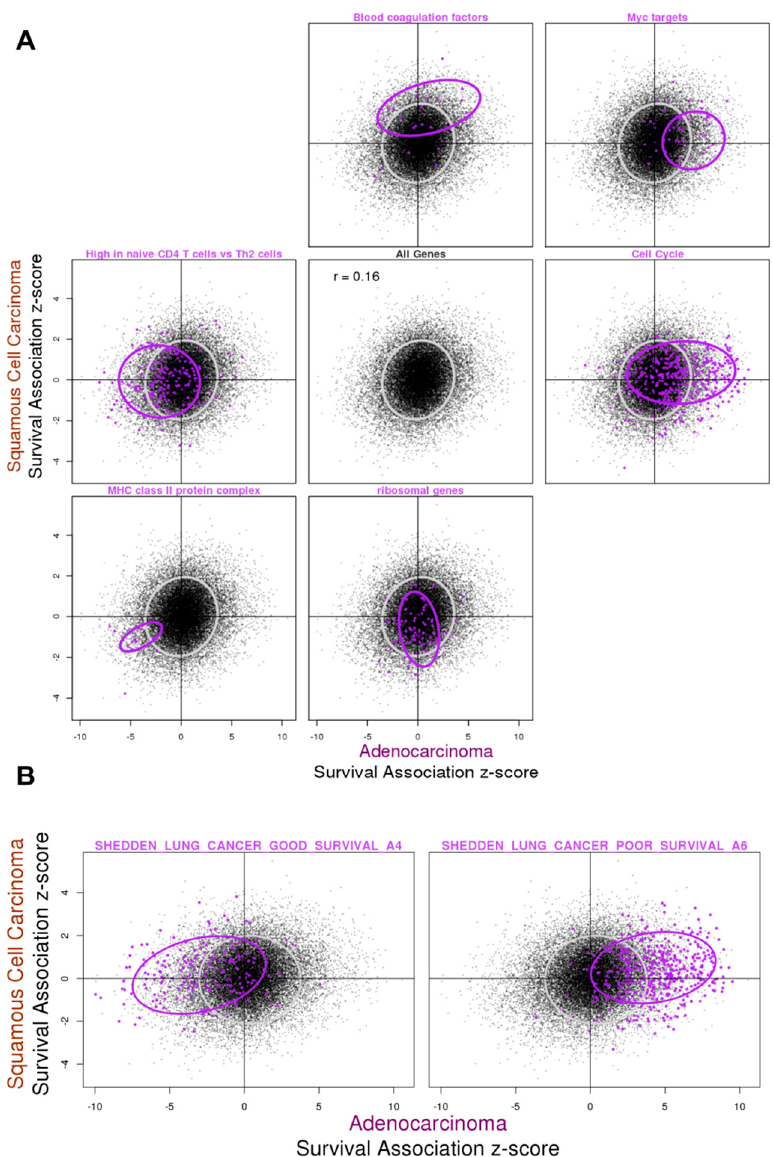
Figure 3. Gene expression survival associations in ADC and SQCC with selected gene sets highlighted. Summary z -scores from the meta-analysis of gene expression survival association based on the Cox-PH model were plotted for all genes, with the results from ADC on the x -axis and results from SQCC on the y -axis. The Pearson correlation coefficient for all genes was 0.16. ( A ) Genes from the selected gene sets coming from the MSigDB gene set collections were highlighted. A selection of gene sets that showed the different patterns for ADC and SQCC association were also highlighted,